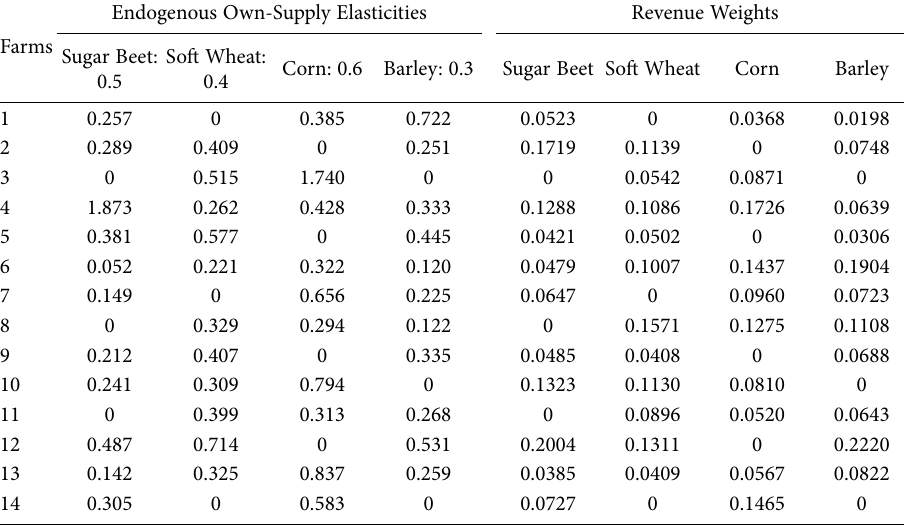
Table 11. Disaggregation/aggregation of the regional, endogenous supply elasticities when some crops are not produced in various